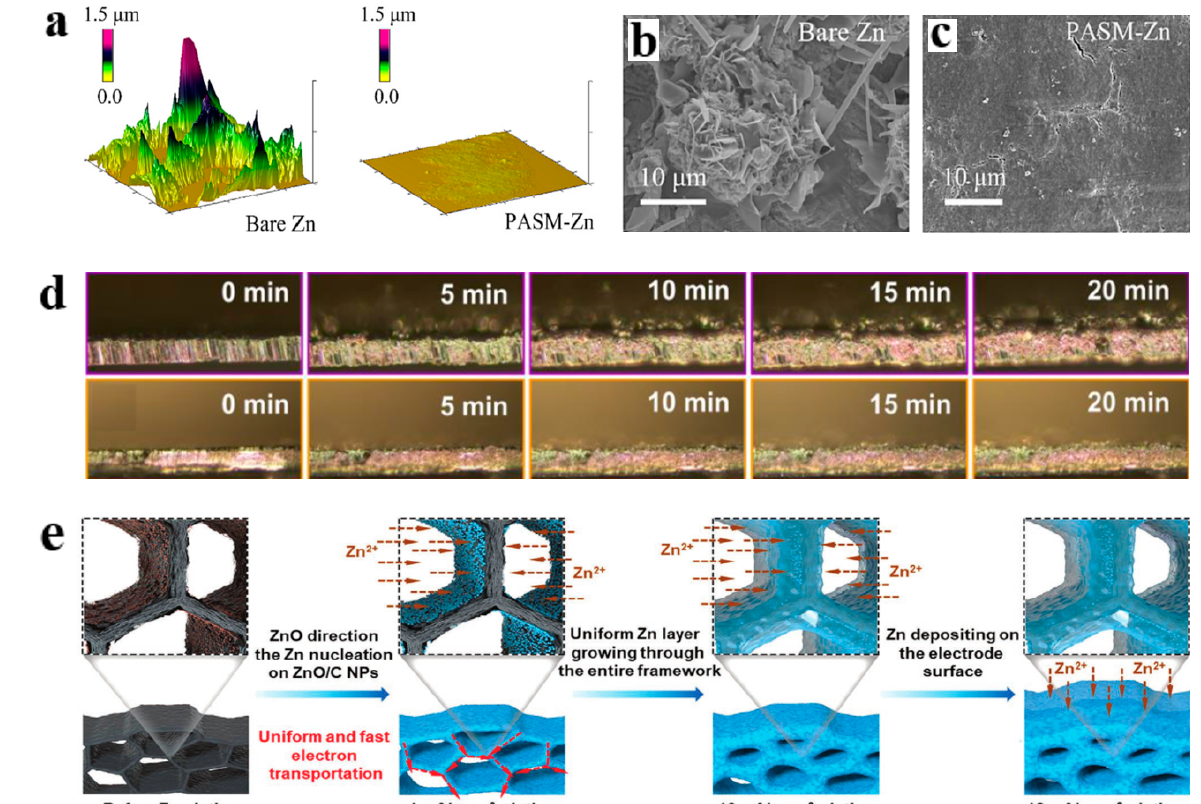
Figure 4. ( a ) AFM images and ( b , c ) SEM images of bare Zn and PASM-Zn after cycling at a current density of 1 mA cm − 2 with an areal capacity of 1 mAh cm − 2 . Reproduced with permission [53]. Copyright 2022 Elsevier B.V. and Science Press. ( d ) In situ optical observation images of Zn deposition on the bare Zn and TCNQ@Zn electrode at 5 mA cm − 2 for 20 min. Reproduced with permission [58]. Copyright 2022 Elsevier B.V. ( e ) Schematic illustration of Zn plating on the 3D-ZGC host in different states. Reproduced with permission [59]. Copyright 2022 Wiley-VCH